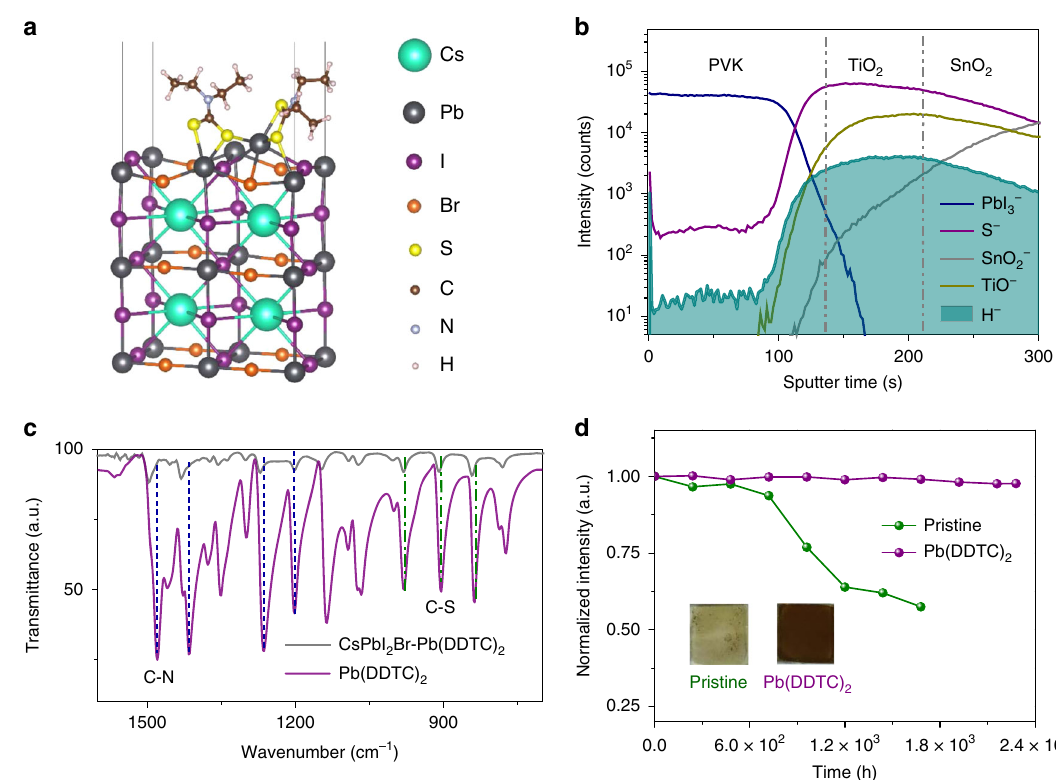
Fig. 1 Chelation characterization and moisture tolerance study. a Atomic structure of optimized CsPbI 2 Br (001) surface with Pb(DDTC) 2 molecule. b ToF-SIMS depth pro fi le of the CsPbI 2 Br perovskite (PVK) fi lm with Pb(DDTC) 2 (chelated CsPbI 2 Br), measured in negative polarity. The measured fi lm was structured as glass/FTO/c-TiO 2 /perovskite. The concentration of Pb(DDTC) 2 used for the chelated sample is 0.015M. c FTIR spectra of Pb(DDTC) 2 (purple) and chelated CsPbI 2 Br (gray) samples. The concentration of Pb(DDTC) 2 and CsPbI 2 Br perovskite in precursor solution are 0.02 and 1.0 M, respectively. C – N stretching and C – S stretching were highlighted by blue and green colored dotted line, respectively. d Evolution of normalized absorbance for pristine (green) and chelated (purple, Pb(DDTC) 2 ) CsPbI 2 Br thin fi lms under dark in ambient atmosphere (RH, 15 ± 3%). Absorption intensities at the wavelength of 400 nm were extracted from the UV – Vis absorption spectra of CsPbI 2 Br fi lms. Insets are the photographs of pristine and chelated CsPbI 2 Br fi lms after exposure to ambient air for 70 and 95 days,